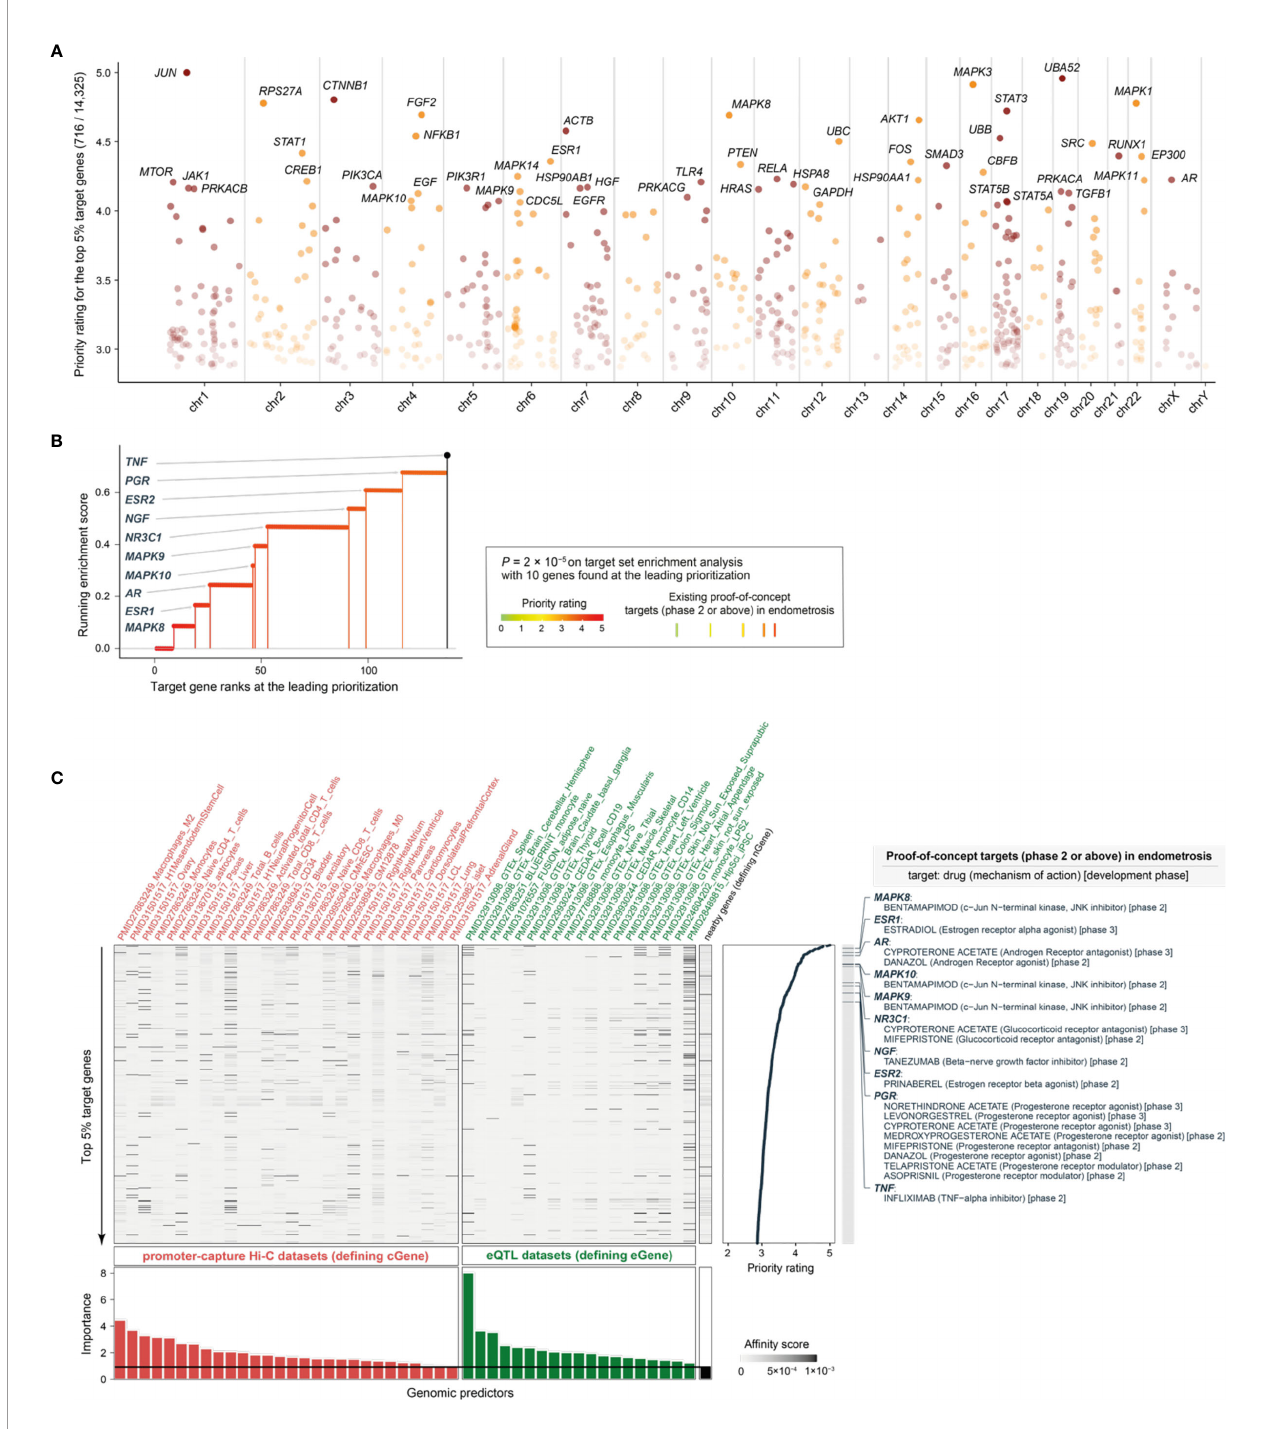
FIGURE 3 | Performance evaluation for prioritization in endometriosis. (A) Manhattan plot illustrating priority rating (y-axis) for top 5% target genes across chromosomes (x-axis), with top 30 named. (B) Leading prioritization plot for clinical proof-of-concept targets in endometriosis, which are indicated in vertical lines (also color-coded by priority rating). (C) Heatmap plot illustrating predictor matrix used in END . Shown beneath is relative importance of predictors (color-coded by dataset types), quanti fi ed by the accuracy decrease (disabling a predictor), and the horizontal line indicates the importance for nGene (that is, the nearby gene predictor that is conventionally used and thus here treated as a baseline predictor). Shown on the right is the information of prioritized target genes (only the top 5% shown for simplicity), together with the information on existing proof-of-concept targets in endometriosis (including drugs, mechanisms of action, and development phases). eQTL, expression quantitative trait